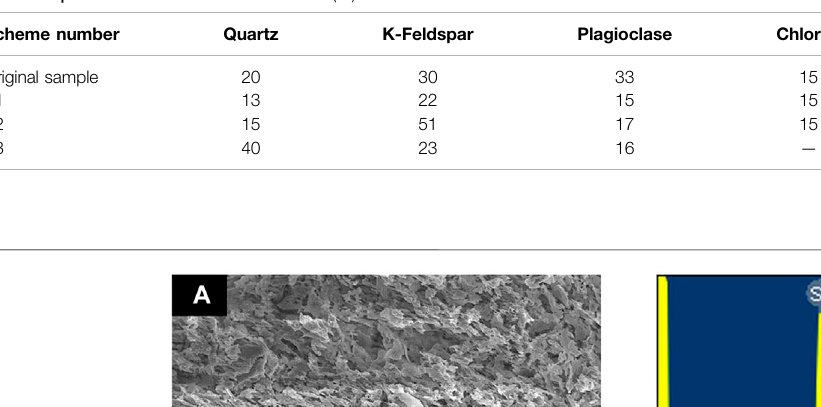
TABLE 3 | XRD results after reaction for 12 h (%).